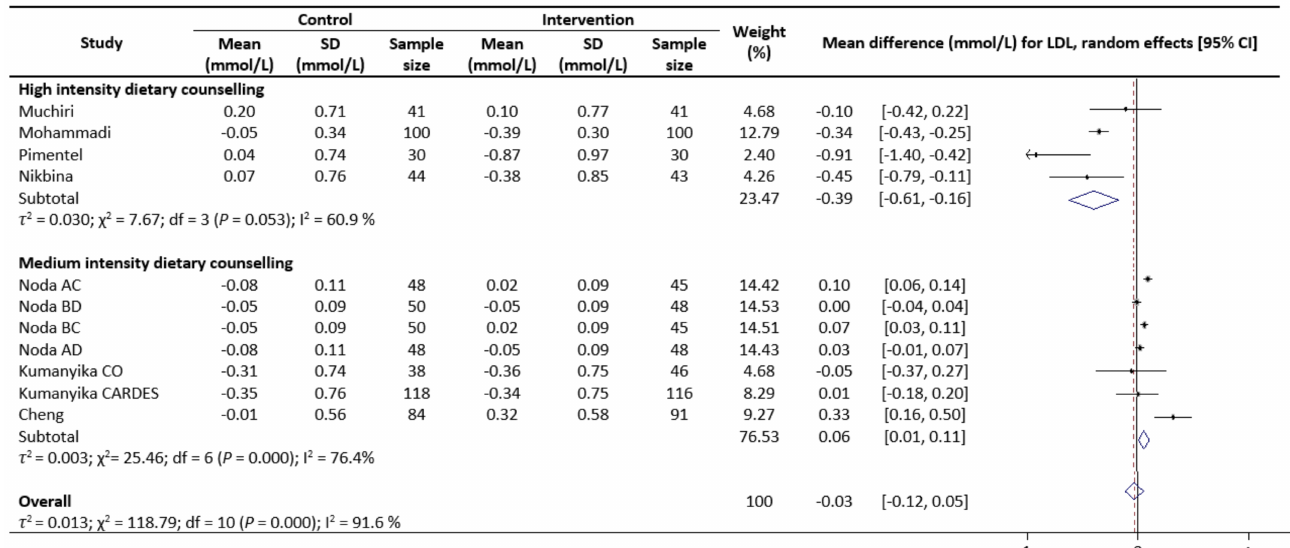
Figure 3. Random-effects model meta-analysis for comparing the changes in LDL of RCTs providing dietary counselling compared to not providing dietary counselling and subcategory analysis in accordance with the intensity level for dietary counselling. Each study is identified by author and year. The horizontal line represents the effect size for each study and the whiskers extending on both sides represent the study effect’s 95% CI. The diamond indicates the overall effect size. Abbreviations: AC, group A and group C; BD, group B and group D; BC, group B and group D; AD, group A and group D; CO, counselling only; CARDES, components of cardiovascular dietary education system.